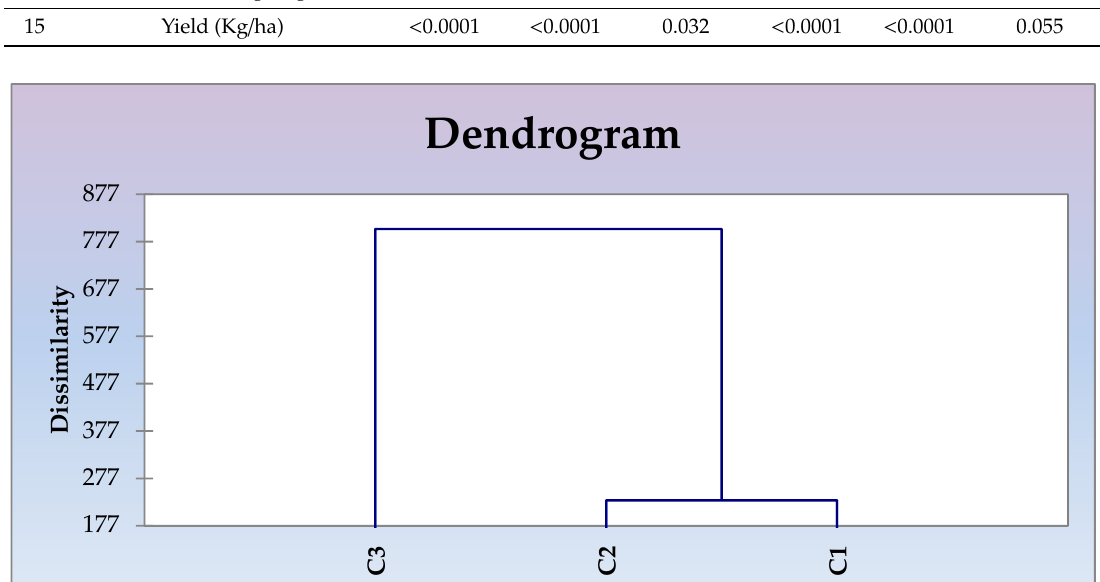
Figure 6. Dendrogram depicting the studied clusters of wild Vigna accessions for the 15 quantitative traits.